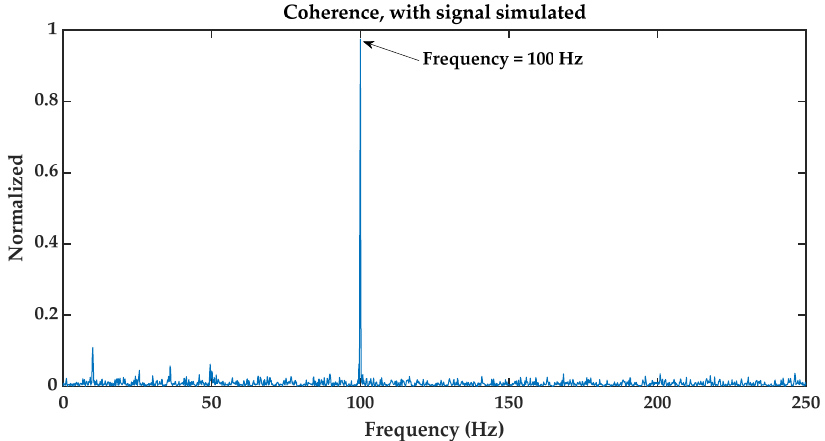
Figure 3. Coherence, with two synthetic signals: S 1 = sin ( 2 π 10 t ) + sin ( 2 π 100 t ) and S 1 = sin ( 2 π 50 t ) + sin ( 2 π 100 t )